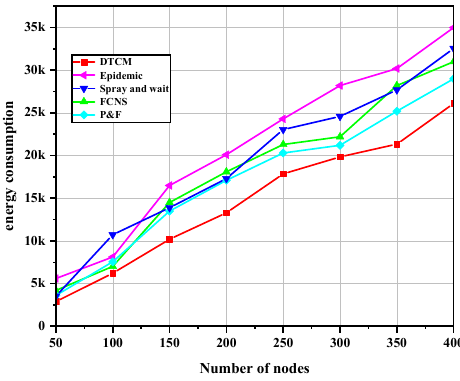
Figure 4. Energy consumption comparison between five algorithms with various number of nodes.